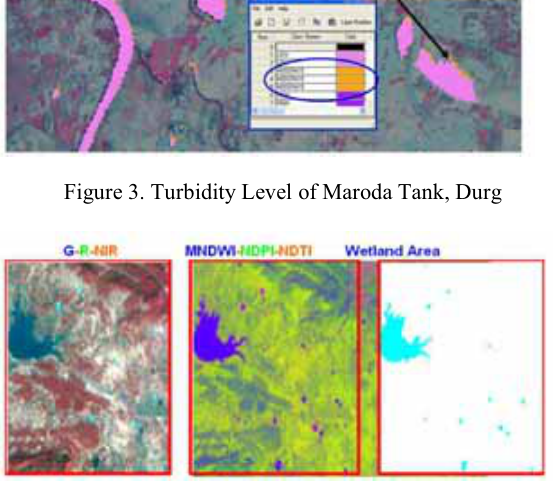
Figure 4. Results of automated Wetland area extraction